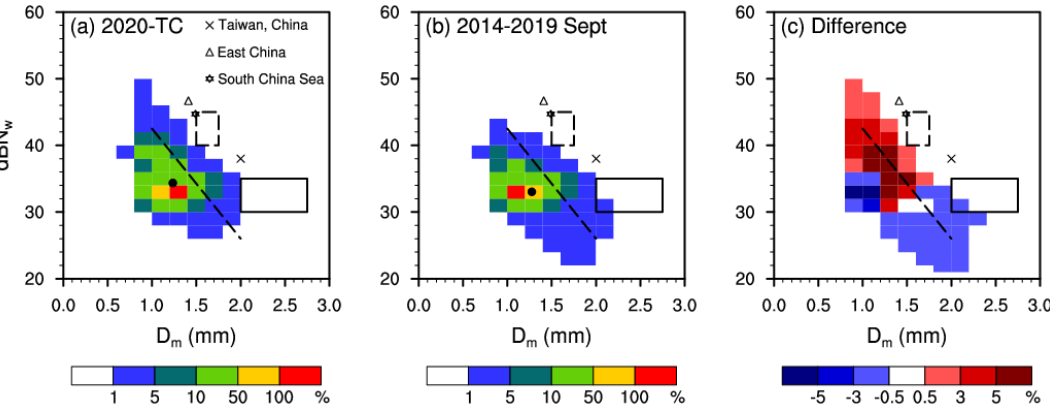
Figure 5. PDFs of near-surface DSD for ( a ) 2020-TC, ( b ) September 2014 – September 2019, and ( c ) their difference (former minus the latter). The PDF is normalized with the overall maximum, and the value of each bin represents the occurrence frequency compared to the absolute maximum frequency: 100% is equivalent to 6201 observations in ( a ) and 44,875 observations in ( b ). The D m interval is 0.2 mm, and the dBN w interval is 2. Dashed line and solid line boxes represent “maritime-like” cluster and “continental-like” cluster proposed by reference [44], respectively.